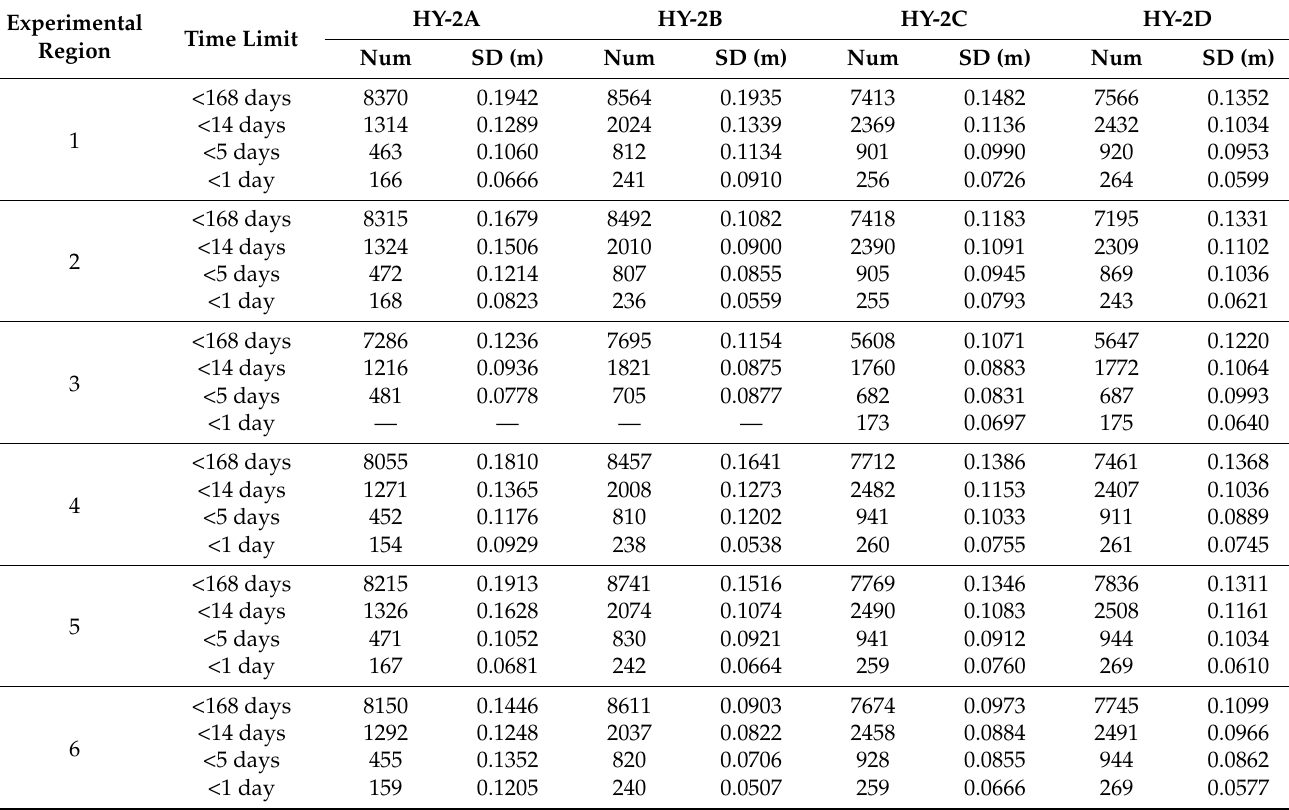
Table 2. Statistics of crossover discrepancy with different time limits for four HY-2 missions: Region 1, Atlantic; Region 6, South